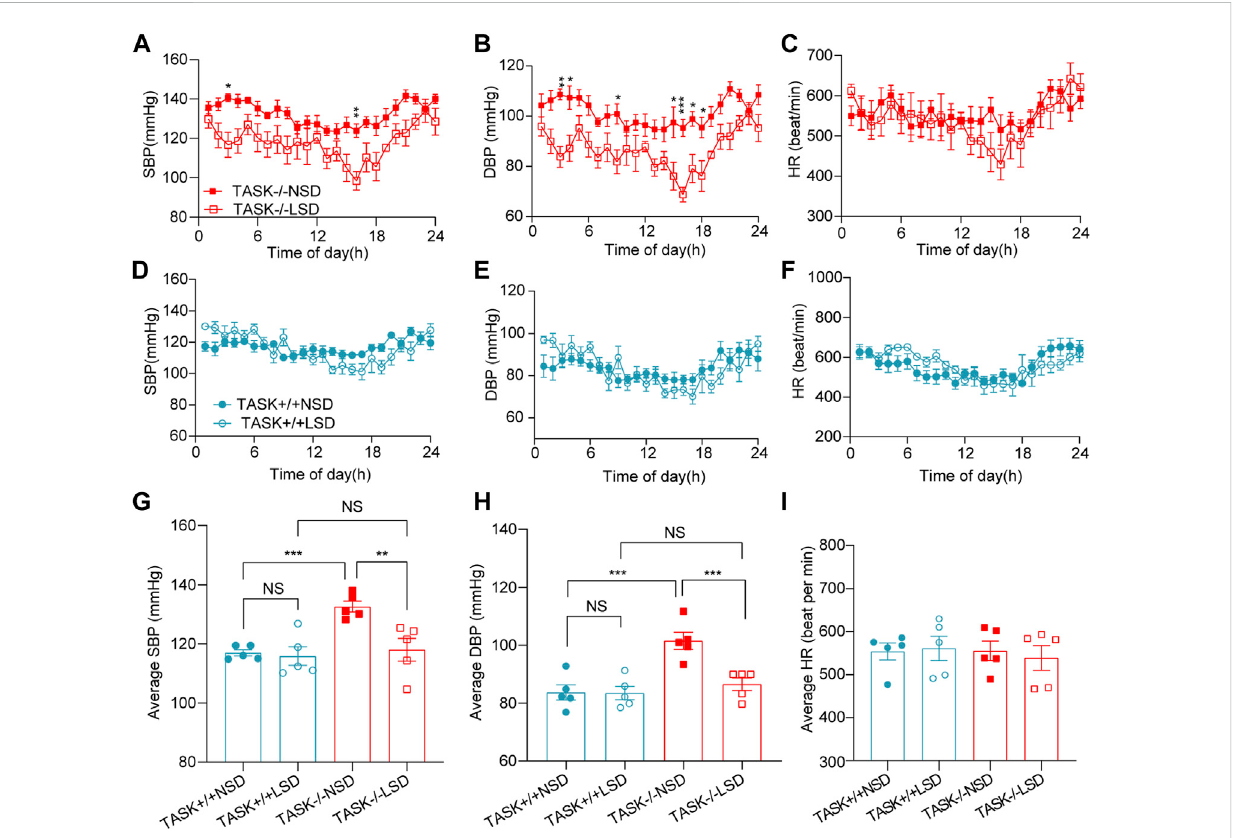
LSD lowers BP in TASK − / − mice. SBP, DBP, and HR were monitored over 24 h in TASK +/+ and TASK − / − mice using a telemetric BP monitoring system. 24 h-dynamic SBP, DBP, and HR measurements of TASK − / − mice (A – C) and TASK +/+ mice (D – F) fed an NSD or LSD for 2 weeks ( n = 5 in each group, * p < 0.05, ** p < 0.01, *** p < 0.0005, two-way ANOVA with Bonferroni ’ s test). (G – I) , 24-h average SBP, DBP, and HR in the various groups (** p < 0.005, *** p < 0.001, one-way ANOVA with Fisher ’ s LSD test). ns, no signi fi cant